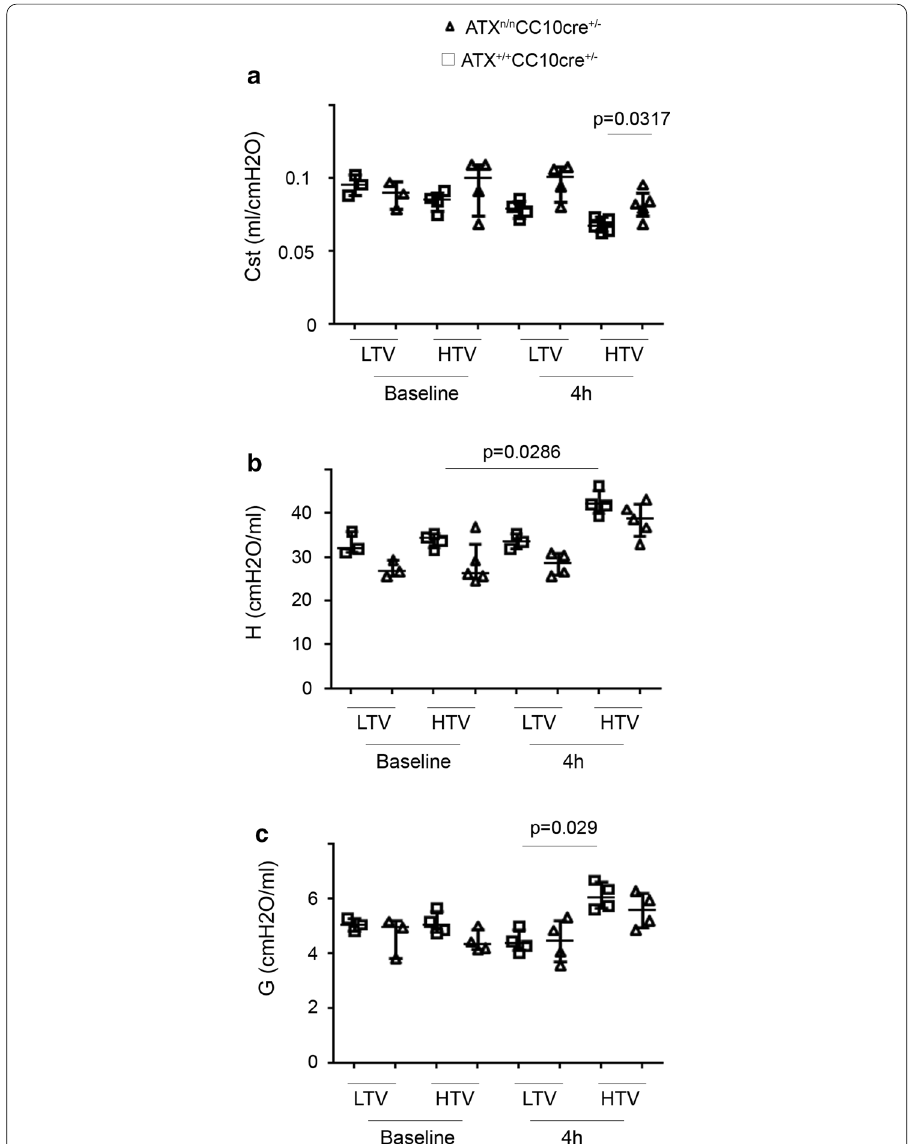
Fig. 3 Evaluation of lung mechanics in all animal groups upon ventilator injury. Lung function parameters were measured using the flexiVent system in mice undergoing ventilation with high (25 ml/kg) or low (8 ml/ kg) tidal volume for 4 h. a Static compliance was evaluated by a single quasi-static pressure–volume curve. Lung tissue elastance b and lung tissue resistance c were evaluated via forced-oscillation technique ( n per group). ATX autotaxin, CC10 Clara cell 10-kDa protein, LTV low tidal volume, HTV high tidal volume, Cst static compliance, H lung tissue elastance, G lung tissue